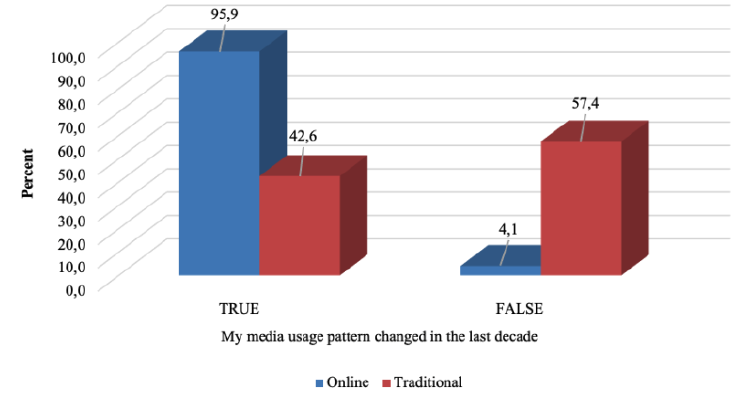
Figure 1: Media usage pattern of tourist